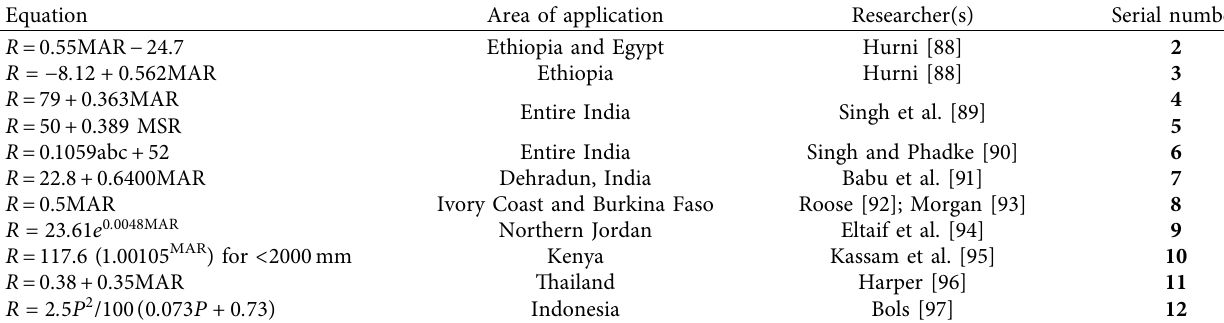
Table 1: The R factor